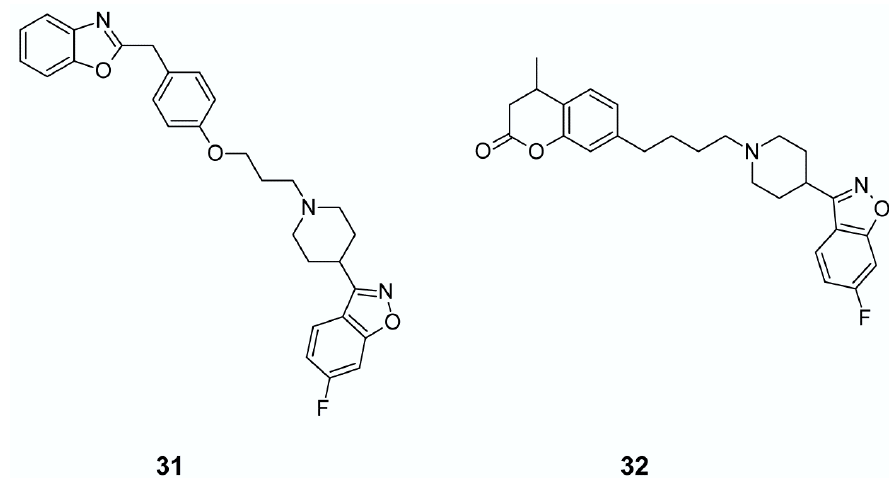
Figure 16. Multi-target ligands of aminergic GPCRs as potential antipsychotics with low affinity to off-targets.